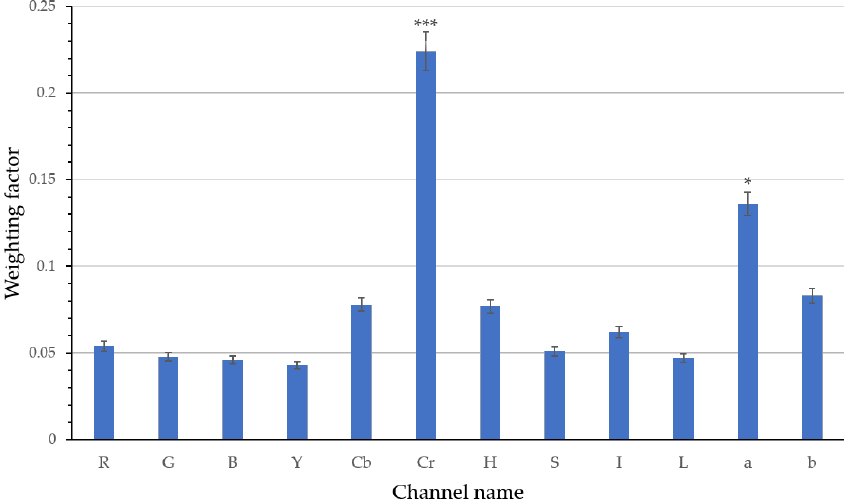
Figure 7. Weight analysis results of single channel. Possible differences in the weight between the channels were tested with an ANOVA. Differences between the channels were pairwise compared via Tukey Contrast using the ‘glht’ function in the ‘multicomp’ package of RStudio version 1.2.5033. (Significance: *** p < 0.001, * p < 0.05). The images of each channel were converted to a pseudo-color dataset to train the